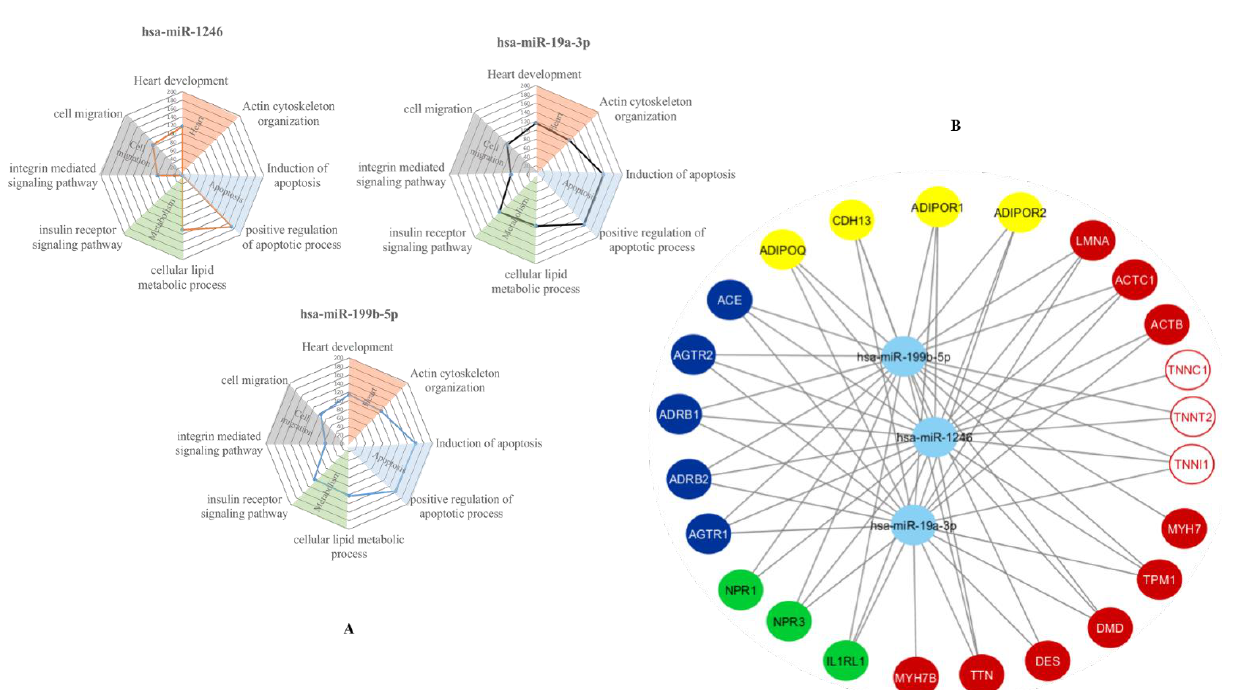
Figure 3. In-silico analysis. ( A ) Radar charts of the relevant biological processes simultaneously modulated by the selected cardiac miRNAs after gene ontology biological processes (GOBP) analysis. The levels show the proportion of the number of putative gene targets for each class of biological process. ( B ) Putative gene targets of selected miRNAs. The light blue circles represent the three validated sequencing miRNA, the yellow circles indicate the gene related to adiponectin system; the blue circle represent the genes involved in angiotensin and adrenergic systems; the green circle indicate natriuretic peptides receptors and Suppressor tumorigenicity 2; the red circles represent the sarcomere genes and the circle white and red the troponin genes. Arrows indicate the relationship between each miRNA and its putative targets.